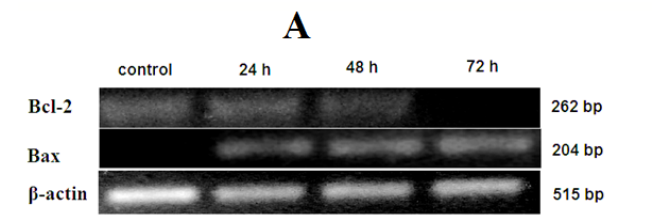
Figure 10. Effect of TPHE on mRNA expression of Bax and Bcl-2 in MCF7